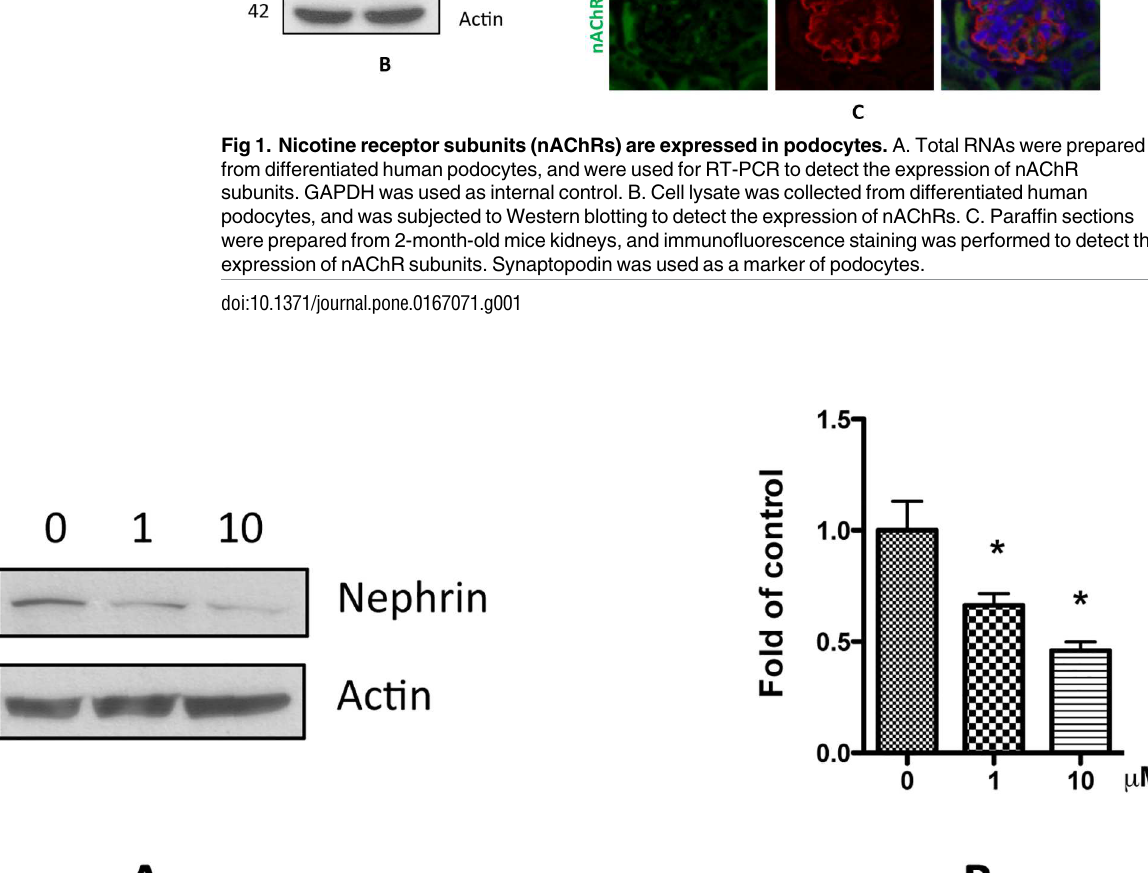
PLOS ONE | DOI:10.1371/journal.pone.0167071 December1,